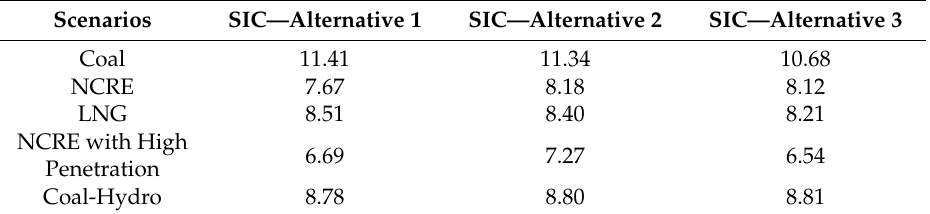
Table 4. Average free price differential in simulated scenarios for the SIC, in US$/MWh.